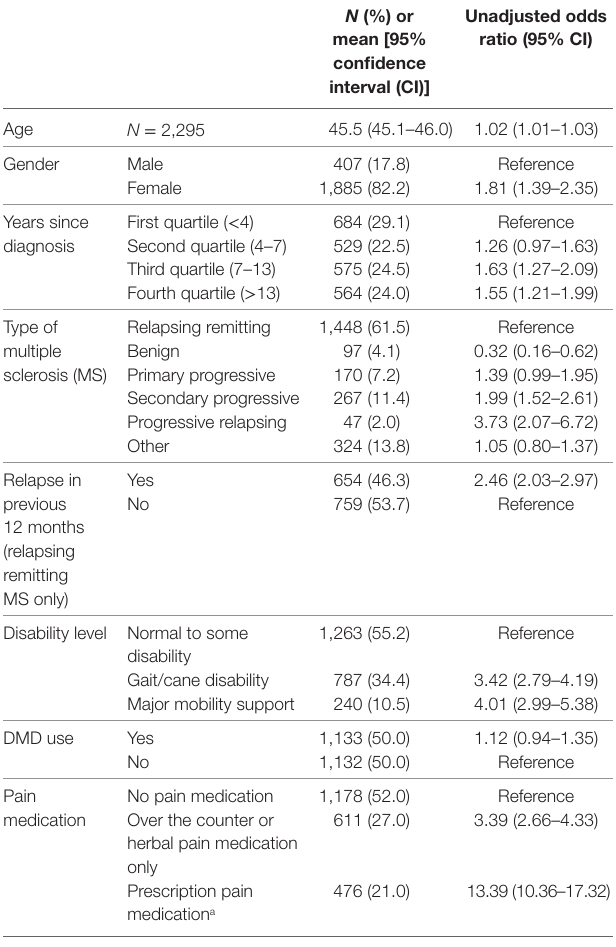
TaBle 1 | Sample characteristics and their unadjusted associations with substantial pain obtained using univariable regression